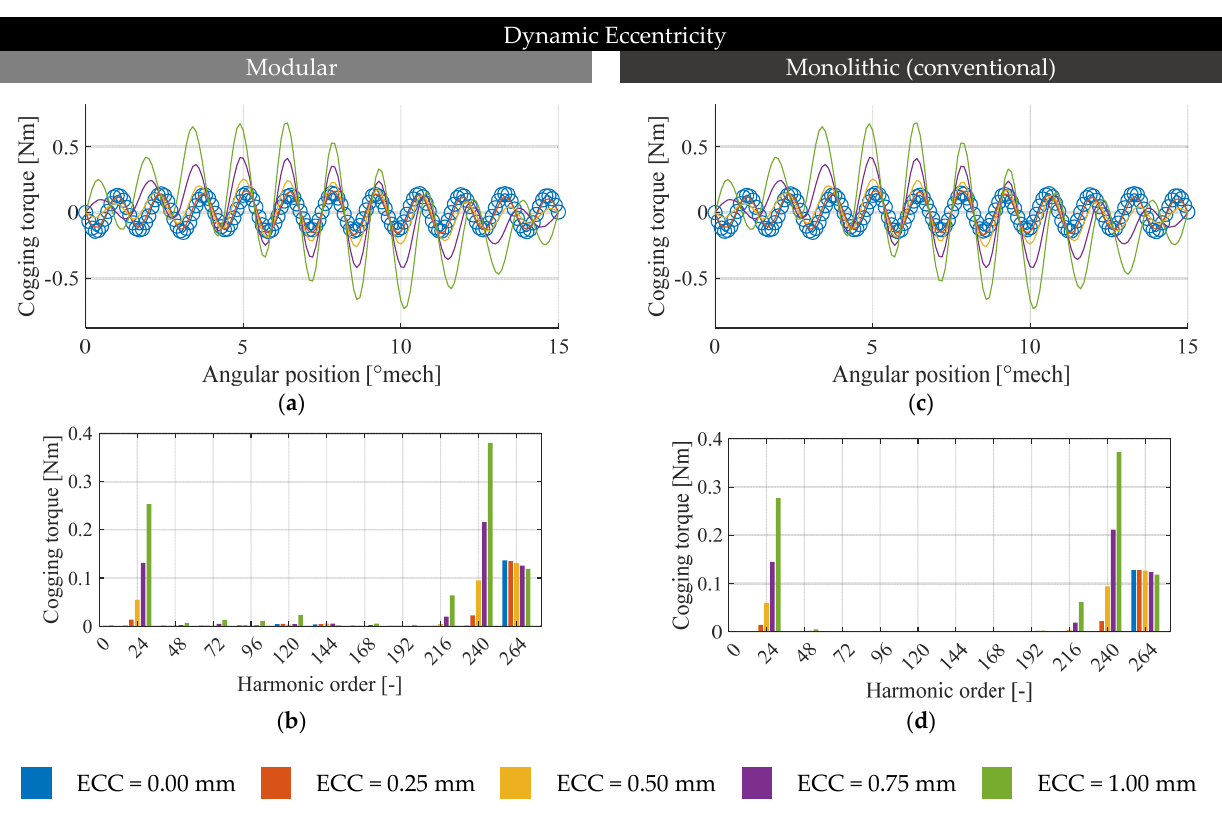
Figure 6. FE evaluation of cogging torque in the presence of DE for the 24-slot, 22-pole PMSM and MPMSM: ( a ) cogging torque waveform for the modular machine, ( b ) cogging torque spectrum for the modular machine, ( c ) cogging torque waveform for the monolithic machine, ( d ) cogging torque spectrum for the monolithic machine.